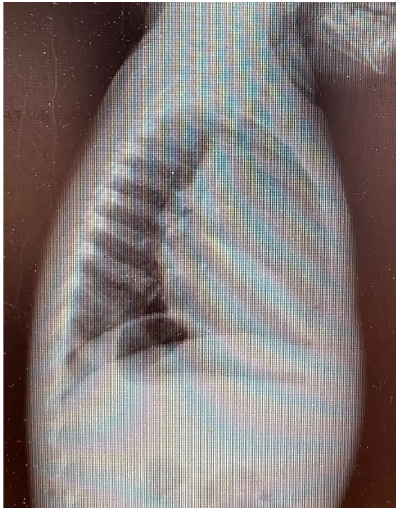
Figure 1. Lateral chest radiography.